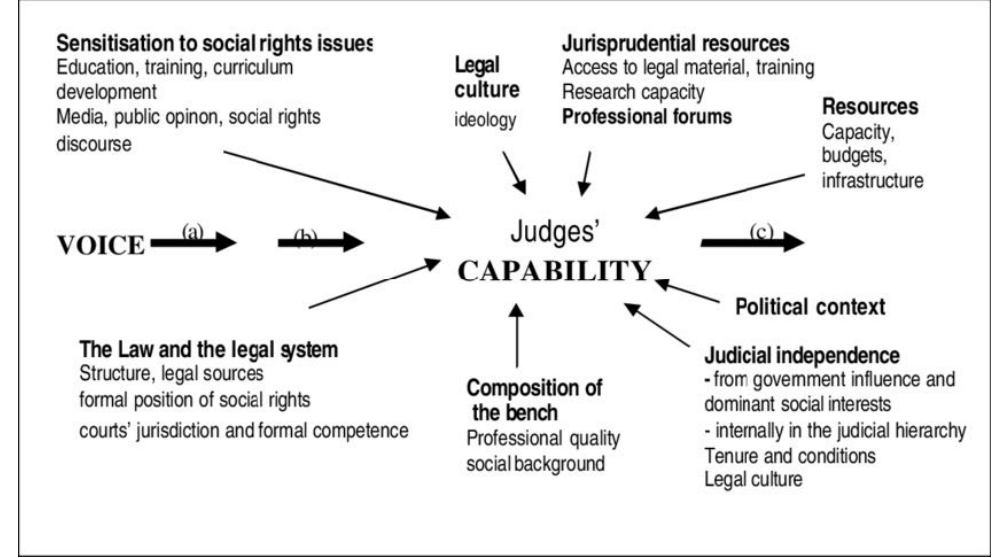
Fig. 2 Schematic diagram of distance factors affecting